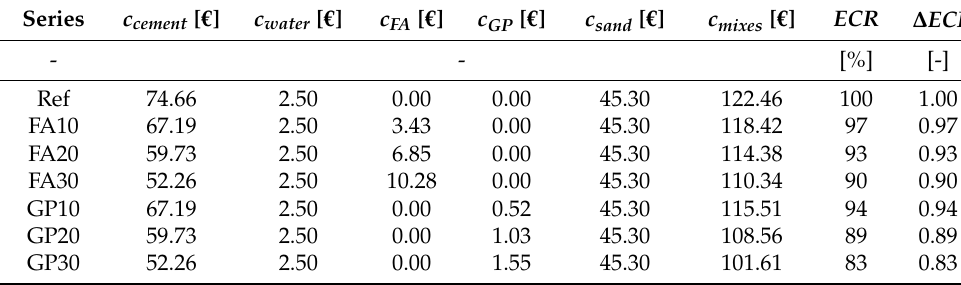
Table 3. Economic performance of the properties of the cementitious mortars.